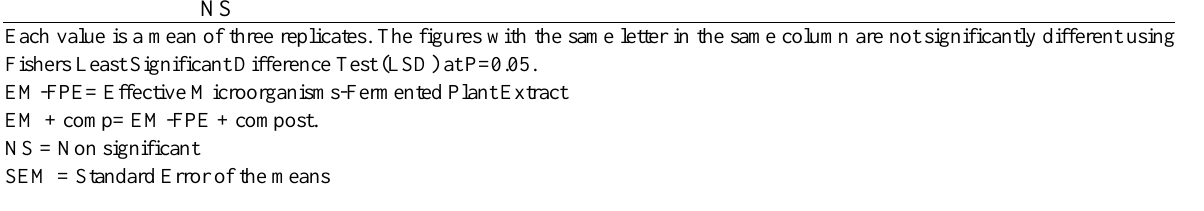
Table 2 Effect of treatment on the height of Meloidogyne incognita infected tomato plants under screenhouse condi- tions Treatments Compost EM+Comp